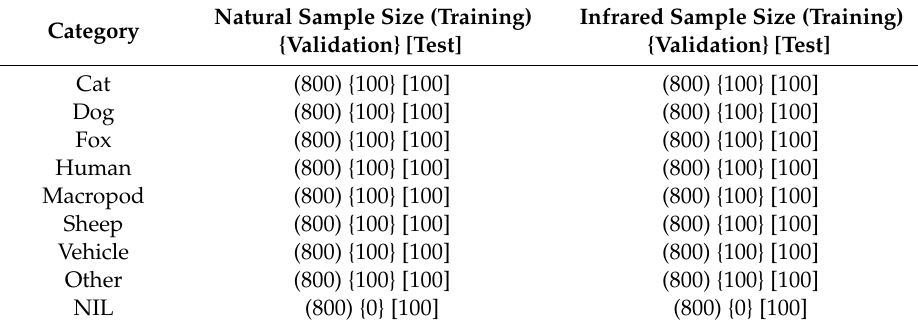
Table 1. Composition of New England, New South Wales, Australia data set. Data was partitioned according to ‘Natural’ daylight illumination and ‘IR’ Infrared Illumination along with Category.